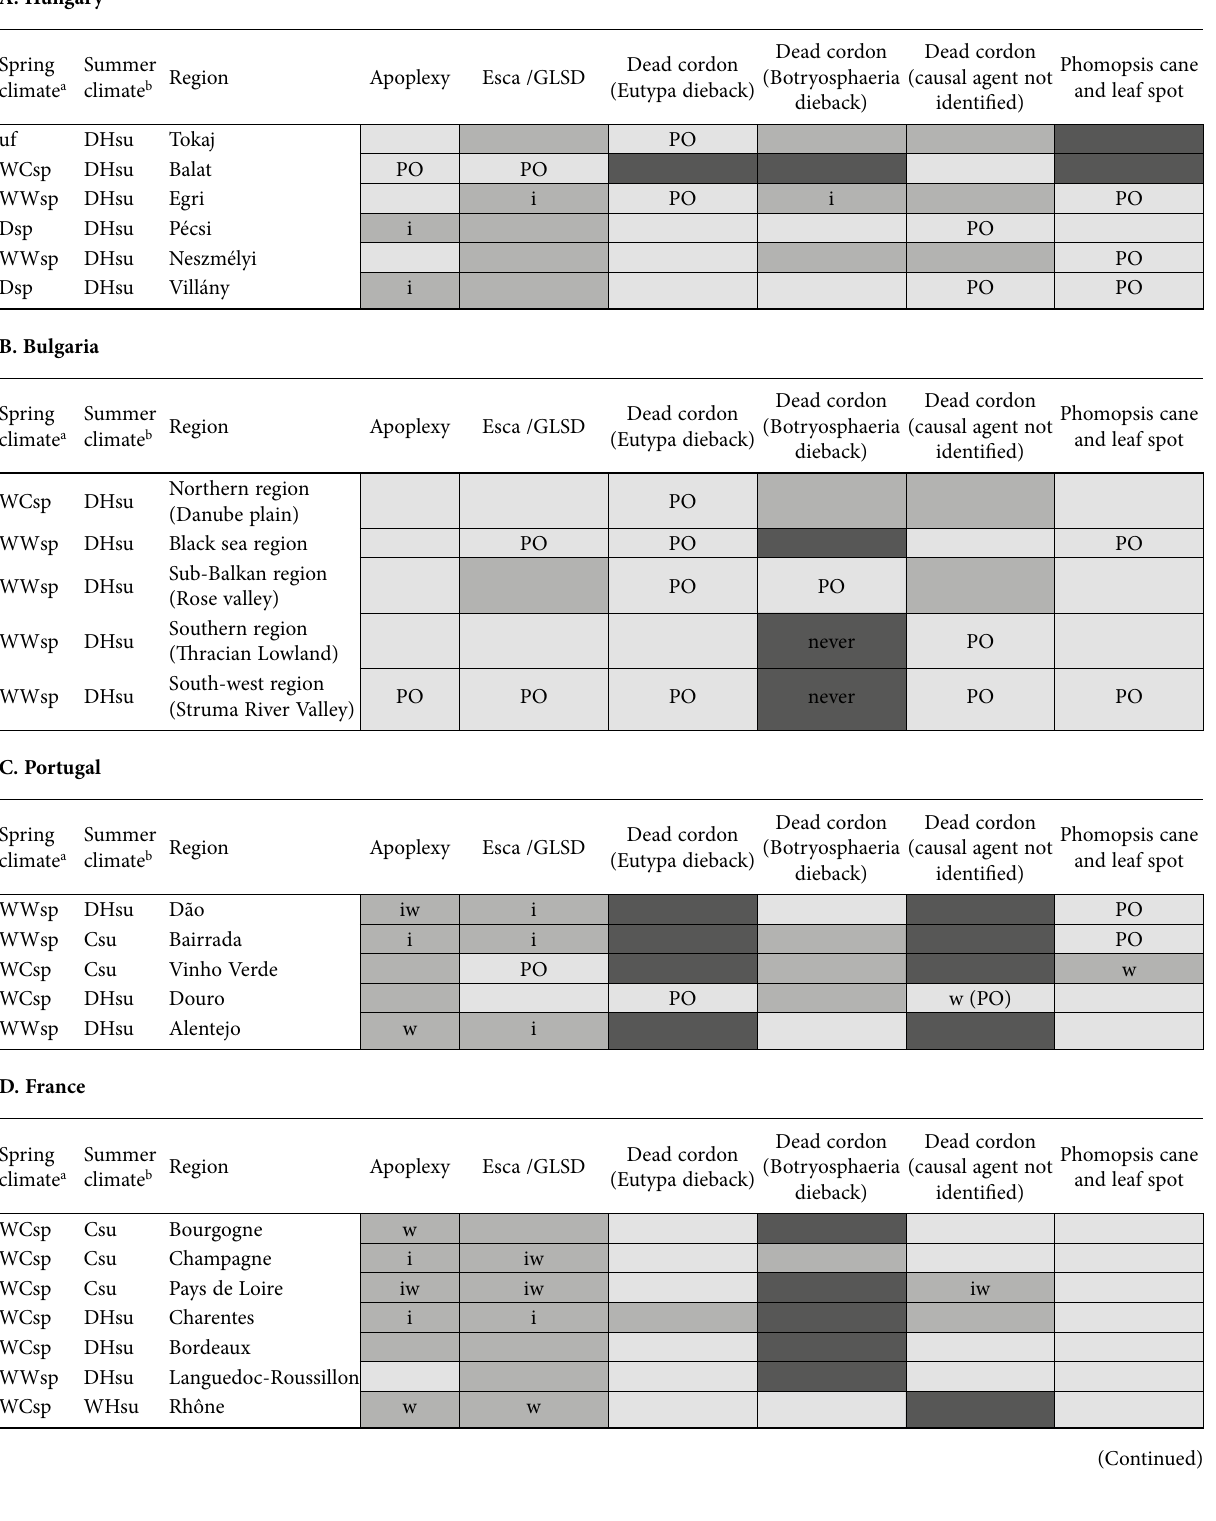
Table 6. Reported levels of occurrence of GTD on adult grapevines in surveyed regions in five selected countries: Hungary (A), Bulgaria (B), Portugal (C), France (D), Italy (E). i, increasing incidence; w, worrying presence; iw, increasing and worrying P, present; PO, present occasionally. Legend: light grey : present but not frequent; medium grey: frequent; dark grey: absent or not